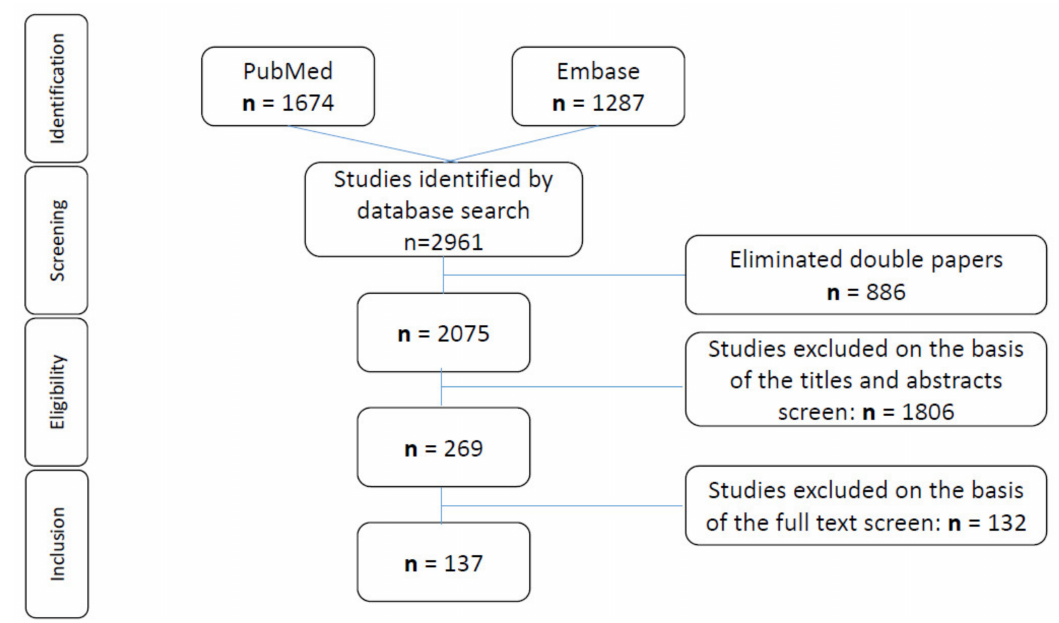
Figure 1. Search criteria. Flow diagram of the search strategy and evidence acquisition in a systematic review on adrenocor- tical carcinoma in childhood.